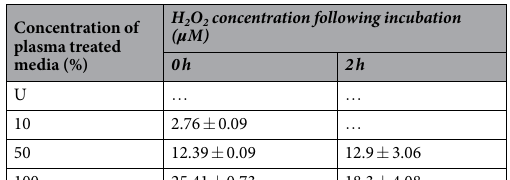
Concentration of plasma treated media (%)